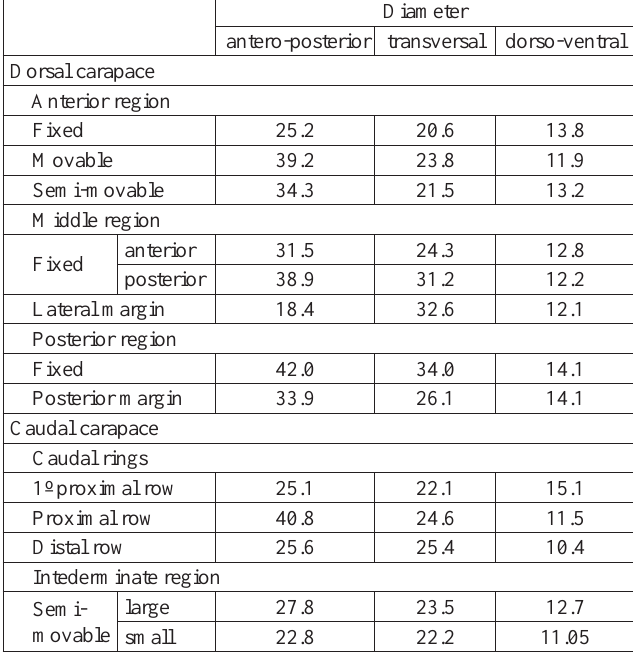
Table 1. Average measurements (in mm) of Palaehoplophorus meridi- onalis osteoderms (MPM-PV 17410, MACN A